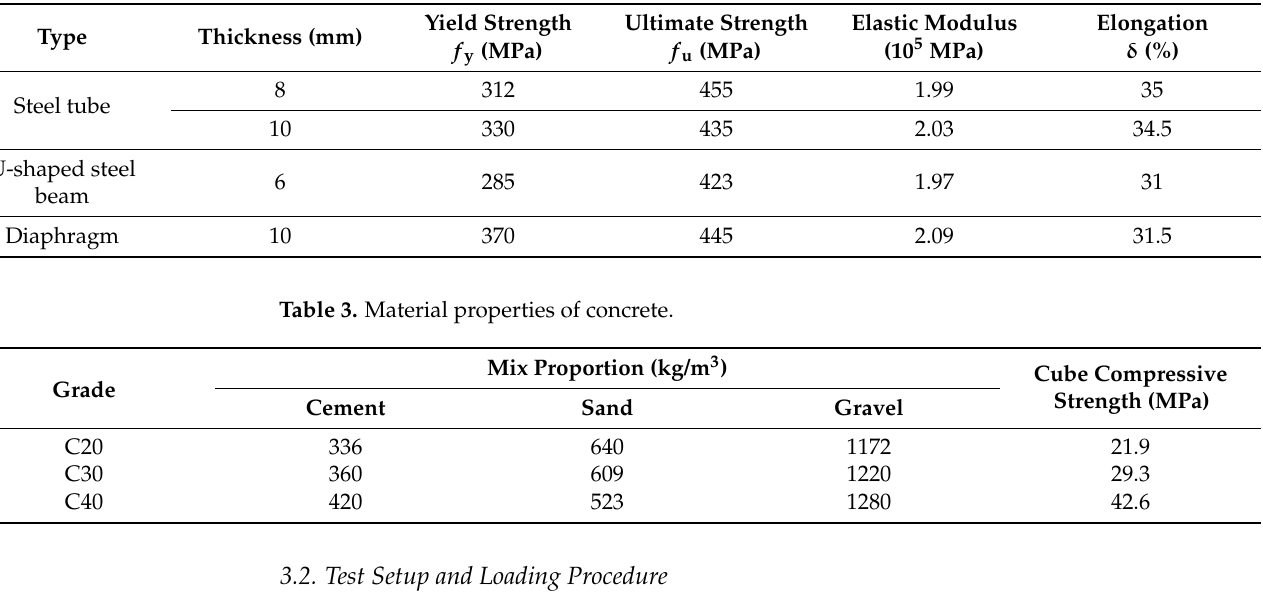
Table 2. Material properties of steel.